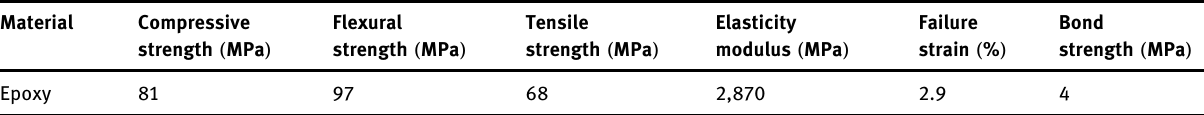
Table 3: Properties of epoxy